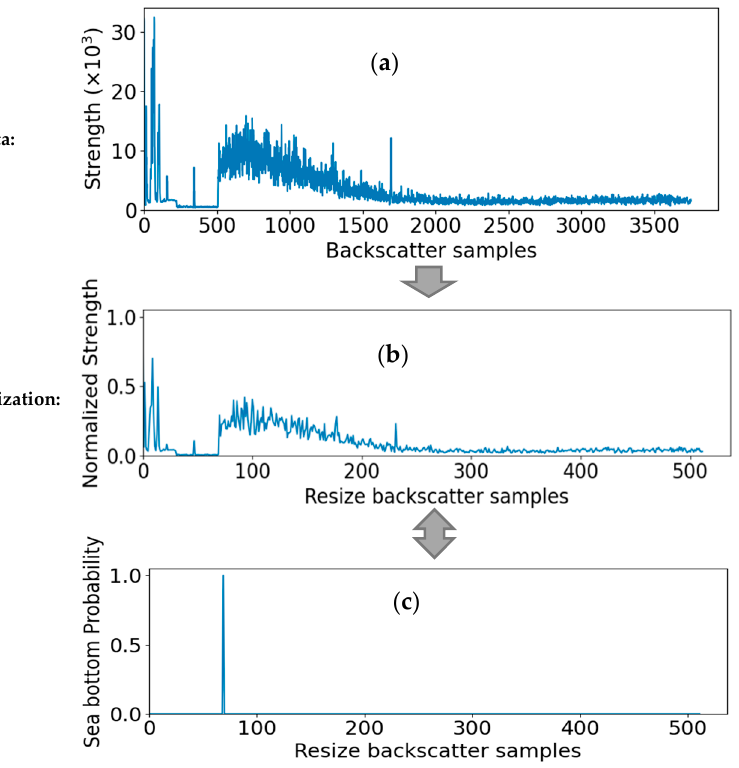
Figure 3. Sampling (input and output) for the 1D-UNet model. ( a ) is the raw backscatter strength sequence of a ping port-side data. ( b ) shows normalization and resizing of the sequence. ( c ) shows the corresponding sea bottom probabilities of each backscatter sample.